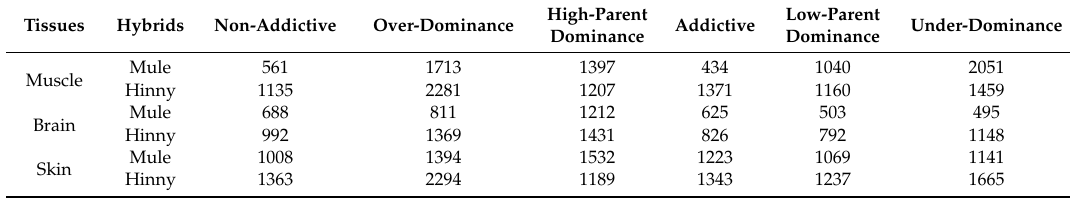
Table 2. Classification of DEGs via gene expression